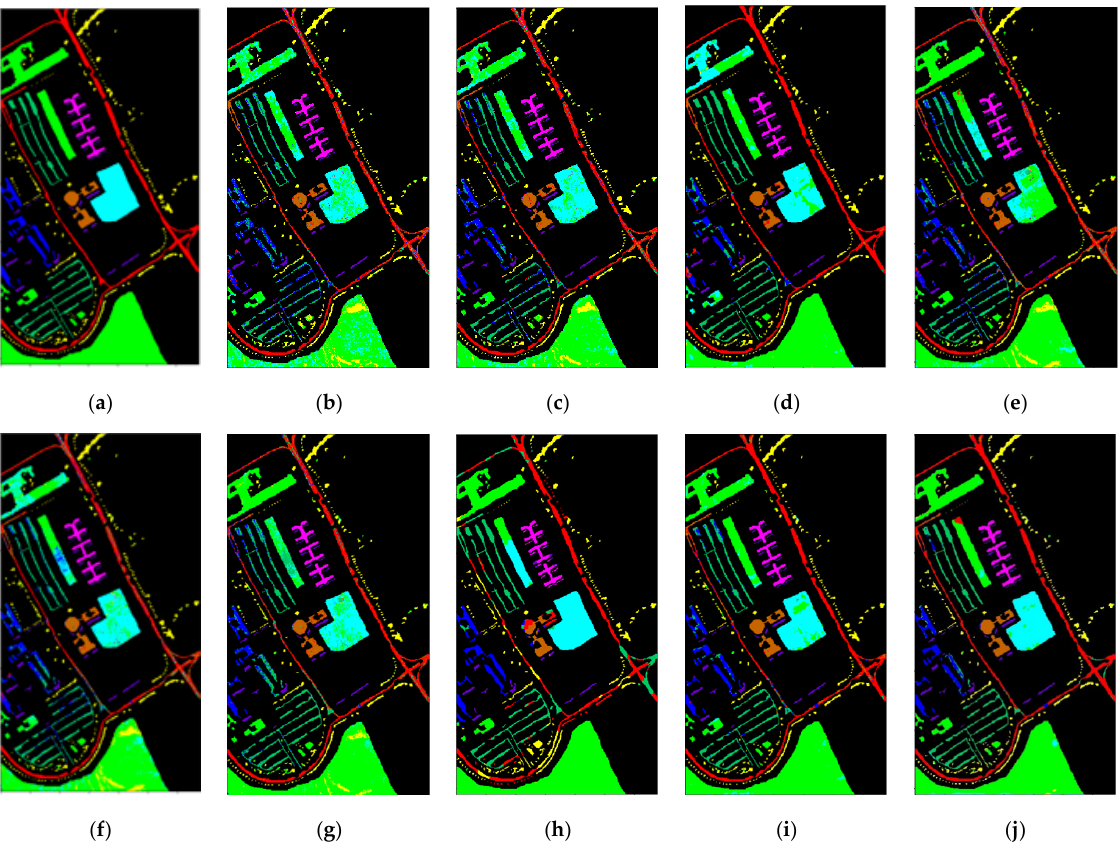
Figure 9. Classification map of various algorithms in the Pavia University data set (( a ) Gound-truth map; ( b ) KNN; ( c ) SVM; ( d ) 2D-CNN; ( e ) CNN-PPF; ( f ) GCN; ( g ) miniGCN; ( h ) MDGCN; ( i ) FuNet-C; ( j ) SSOGCN).